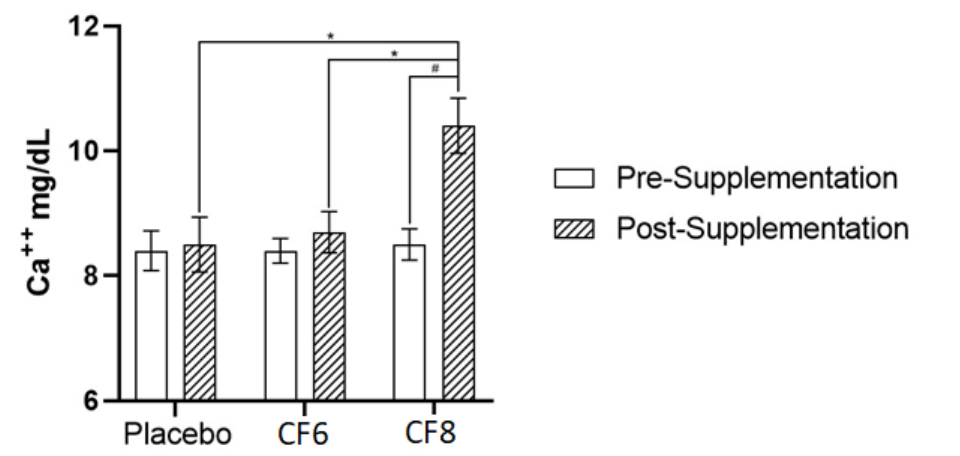
Figure 3. Calcium release 45 min after supplementation. * = significant differences ( p < 0.05) compared to placebo and CF6; # = significant difference ( p < 0.05) compared to pre-supplementation.